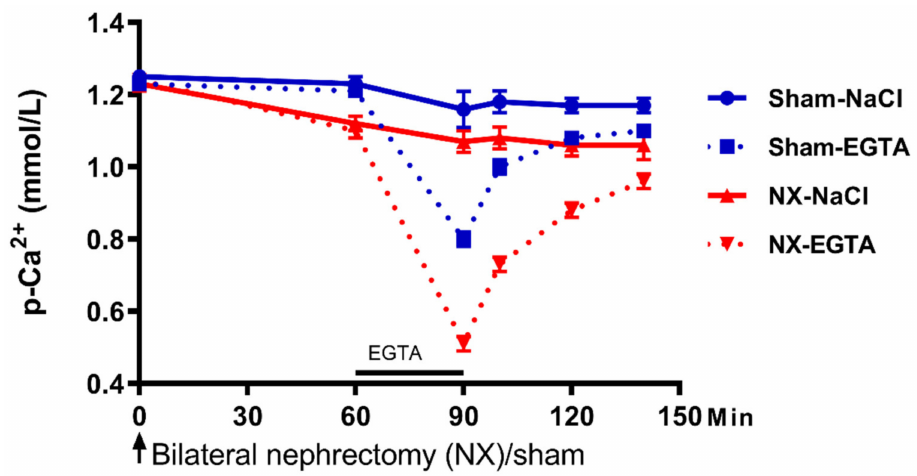
Figure 3. The role of the kidney in setting the set point for calcium sensing. Rats underwent bilateral nephrectomy (NX) or sham surgery. Removal of the kidneys resulted in a significant drop in plasma Ca 2 + , illustrating a role of the kidney in the setting of Ca 2 + set point. The calcium chelator EGTA was infused via the femoral vein and it lowered plasma Ca 2 + in both groups, however, more pronounced in the bilateral nephrectomized rats. The concentration of plasma Ca 2 + remained, at all time points, significantly lower in these rats during recovery from hypocalcemia ( p < 0.01). Data are presented as mean ± SEM. The figure has been published in BMC Nephrol, Nordholm et al., 2015